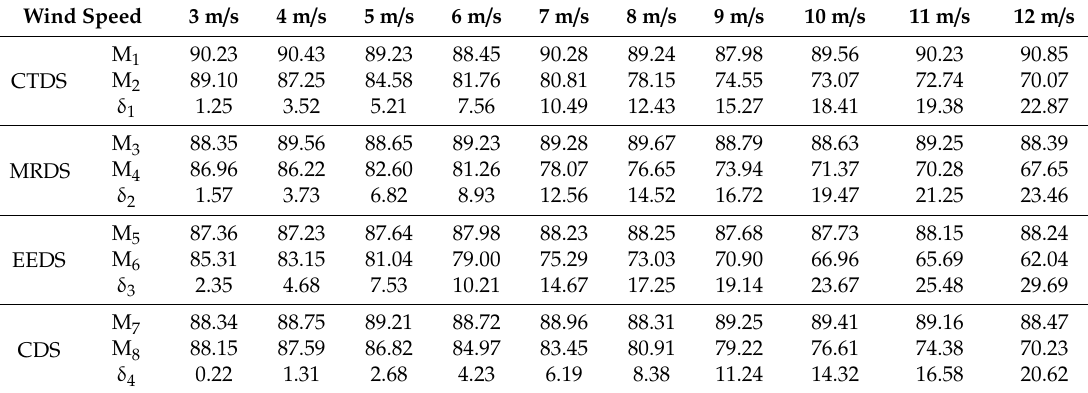
Figure 4. Layout drawing of the erosion rate testing experiment equipment. Table 3. Statistics of wind erosion rate of four dust suppressors.